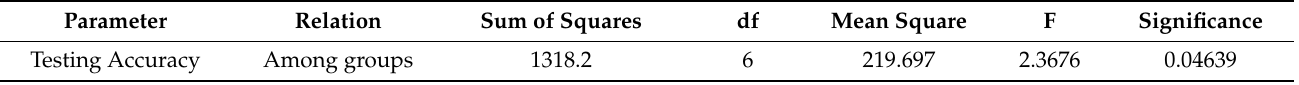
Table 10. One way ANOVA Test Results of PSO